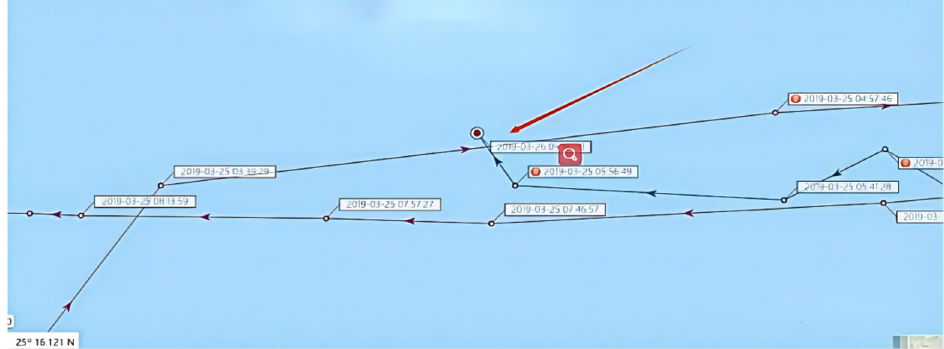
Figure 8. Course conflict scenario between two ships.